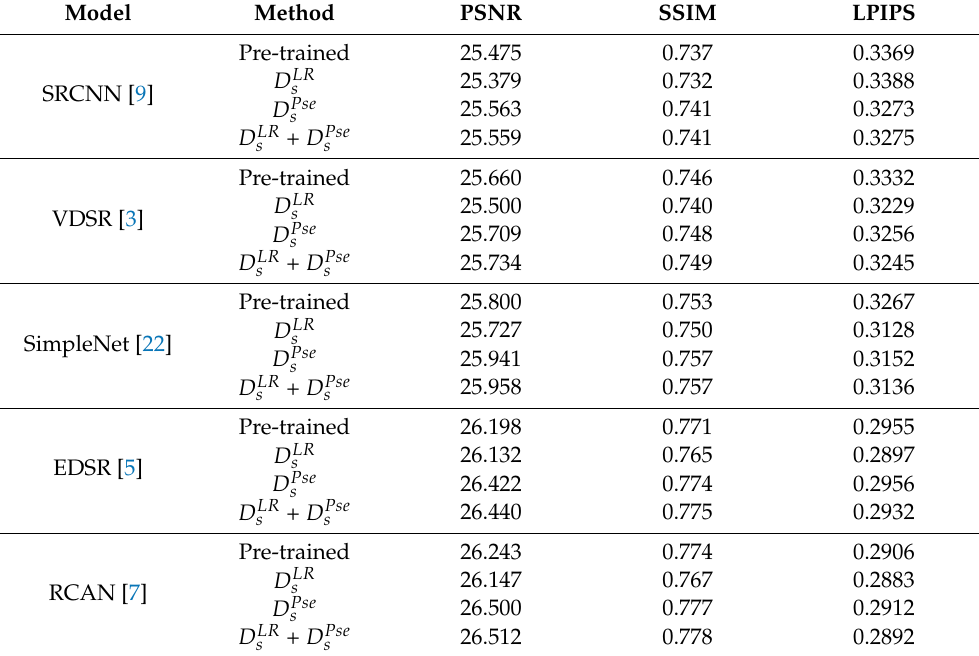
Table 2. SISR online learning results on SISR